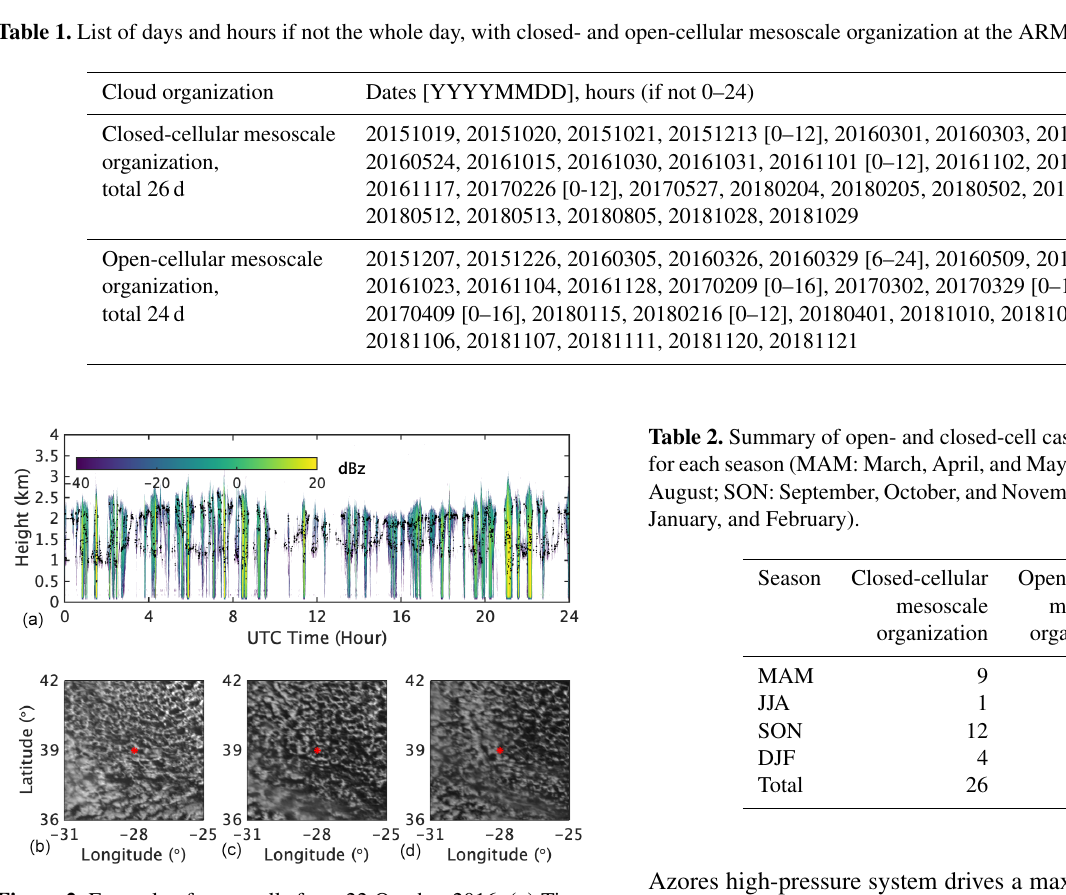
Figure 2. Example of open cells from 22 October 2016. (a) Time– height profile of the best estimate radar reflectivity from the ARSCL value-added product. (b) Reflectance at 0.65µm wavelength from Meteosat observations.